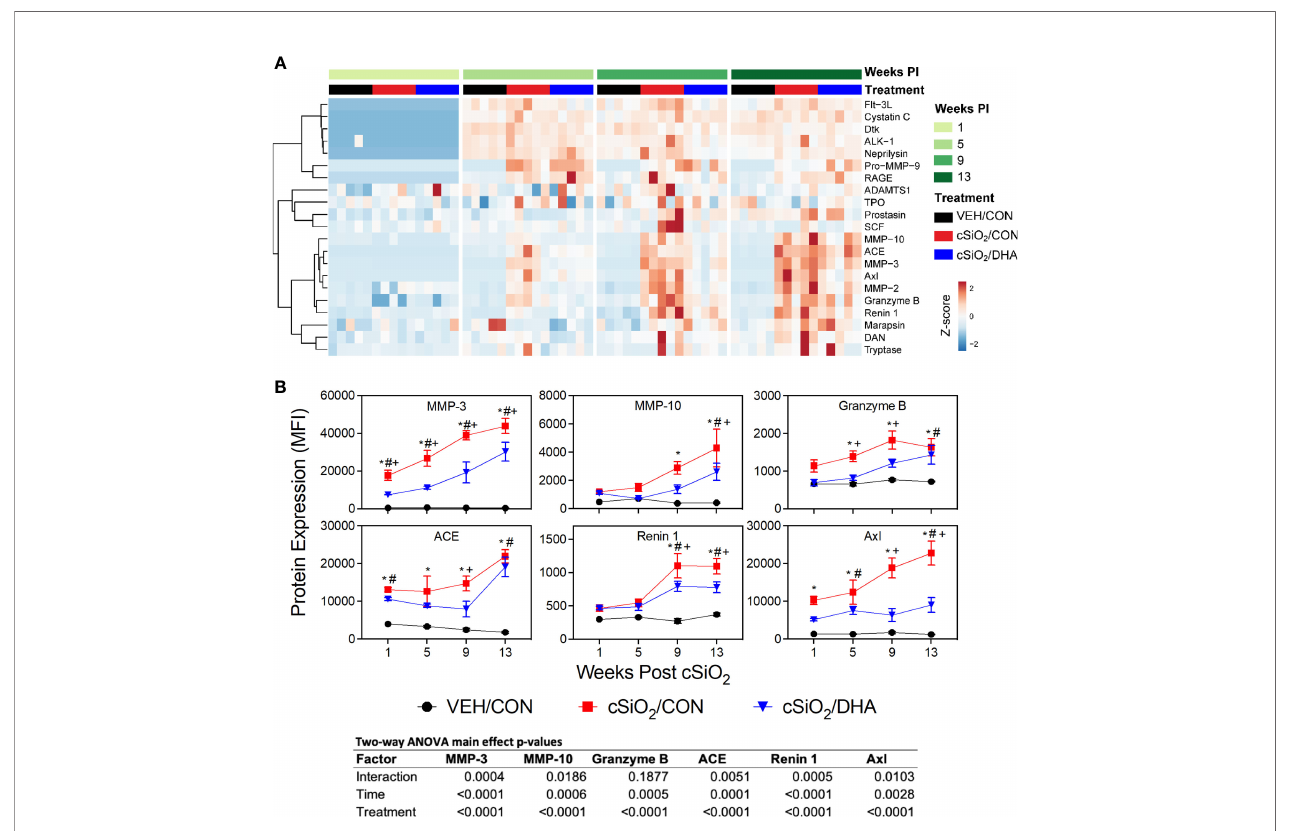
FIGURE 4 | DHA supplementation inhibits cSiO 2 -stimulated release of in fl ammation-associated enzymes into the BALF. (A) Heat map with unsupervised clustering (Euclidian distance method) depicts unit variance-scaled mean fl uorescent intensities (MFIs) for enzyme expression measured in the BALF. Black, red and blue bars above the heat map indicate the VEH/CON, cSiO 2 /CON, and cSiO 2 /DHA groups, respectively, at 1, 5, 9, or 13 wk PI. Scale bar values re fl ect the range of variance- stabilized MFIs, which were centered across rows. (B) DHA diet suppresses cSiO 2 induction of selected enzymes in BALF over time. MFIs were obtained using the microarray panel for VEH- or cSiO 2 -exposed mice fed CON or DHA diets. Data for select proteins were analyzed by two-way ANOVA for main effects of timepoint and treatment with post-hoc Tukey HSD multiple comparison tests to determine effects of treatment at each time point. Data are mean±SEM. Main effect p-values for timepoint, treatment, and the interaction of these factors are shown below the plots. Symbols indicate signi fi cant differences (p ≤ 0.05) as follows: * for cSiO 2 /CON vs. VEH/CON; # for cSiO 2 /DHA vs. VEH/CON; and + for cSiO 2 /CON vs. cSiO 2